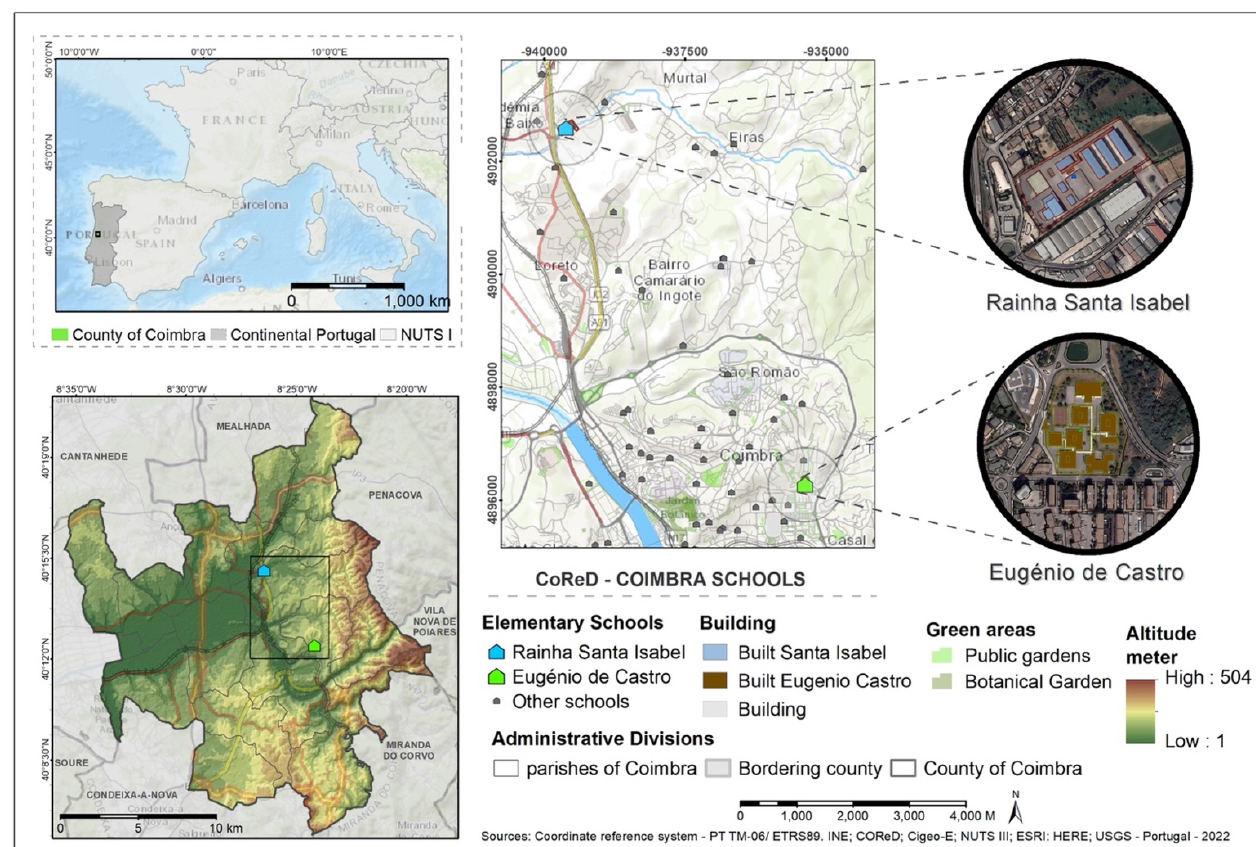
Figure 2. Coimbra Municipality and CoReD schools — Location and main characterization.